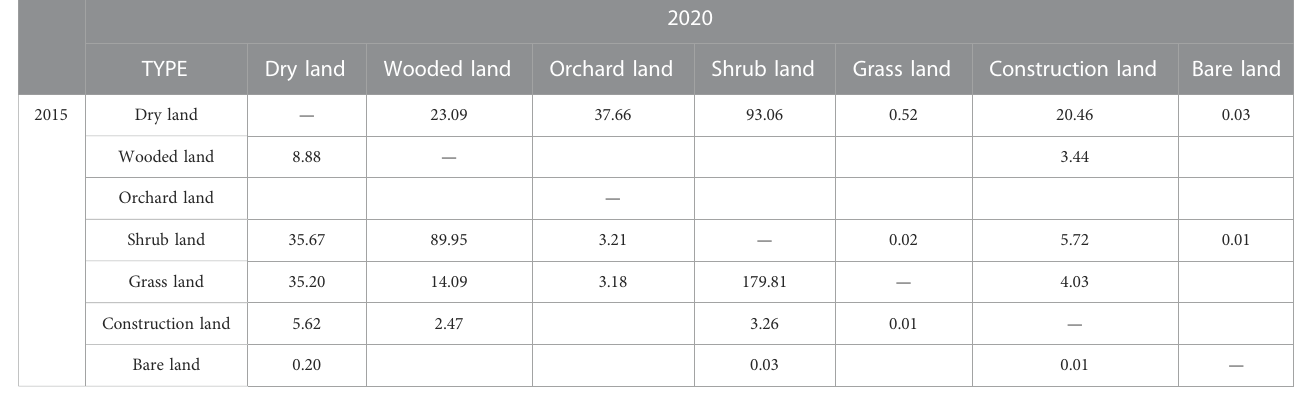
TABLE 4 Land use transfer matrix for 2015 – 2020 in the study area (hm 2 ).